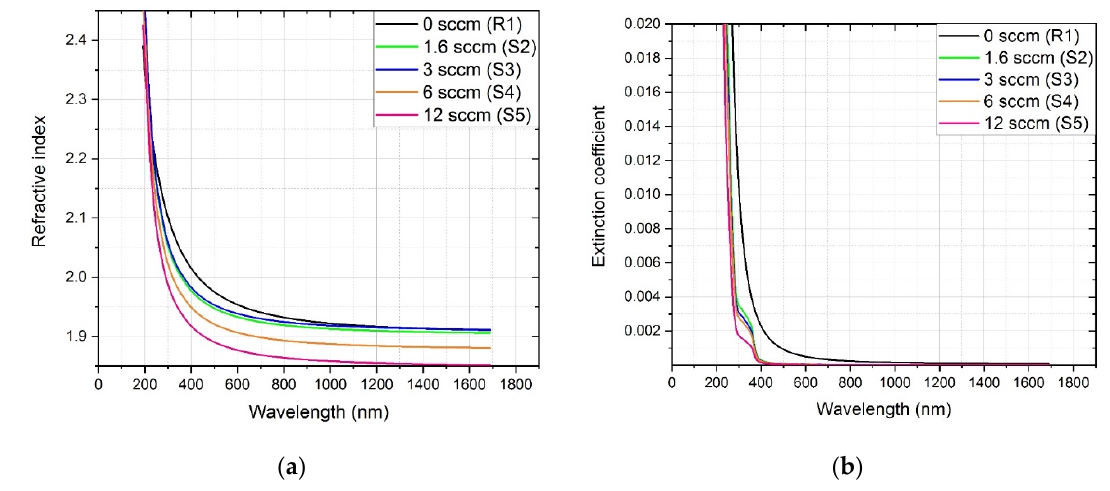
Figure 2. Effect of hydrogen flow on the optical properties of a-SiN x thin films: ( a ) refractive index, ( b ) extinction coefficient.